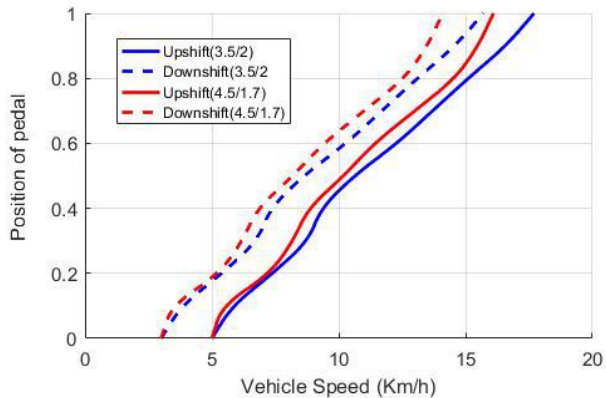
Figure 7. Efficiency curves on different pedal positions.